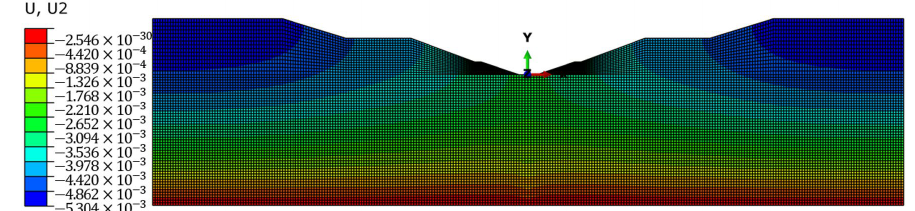
Figure 18. Canal settlement nephogram when t = 50 years.